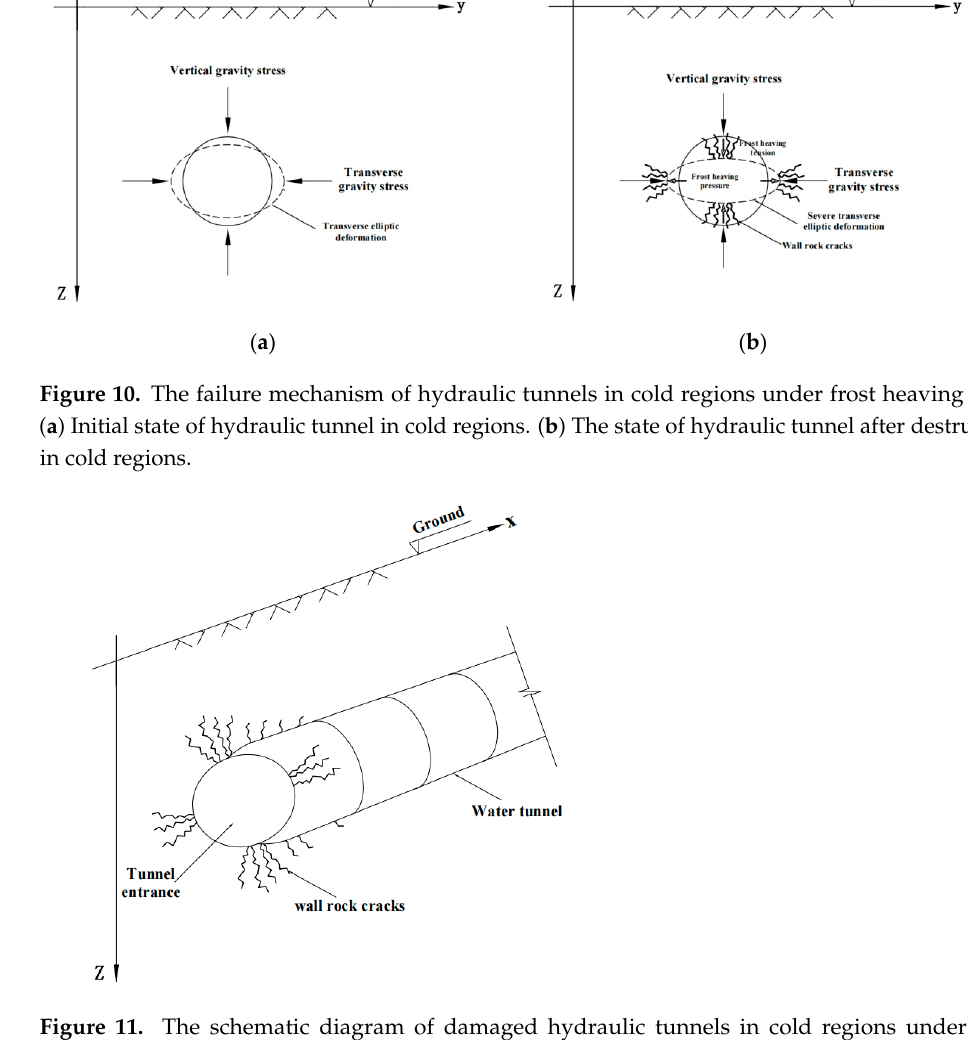
Figure 11. The schematic diagram of damaged hydraulic tunnels in cold regions under frost heav- ing force.